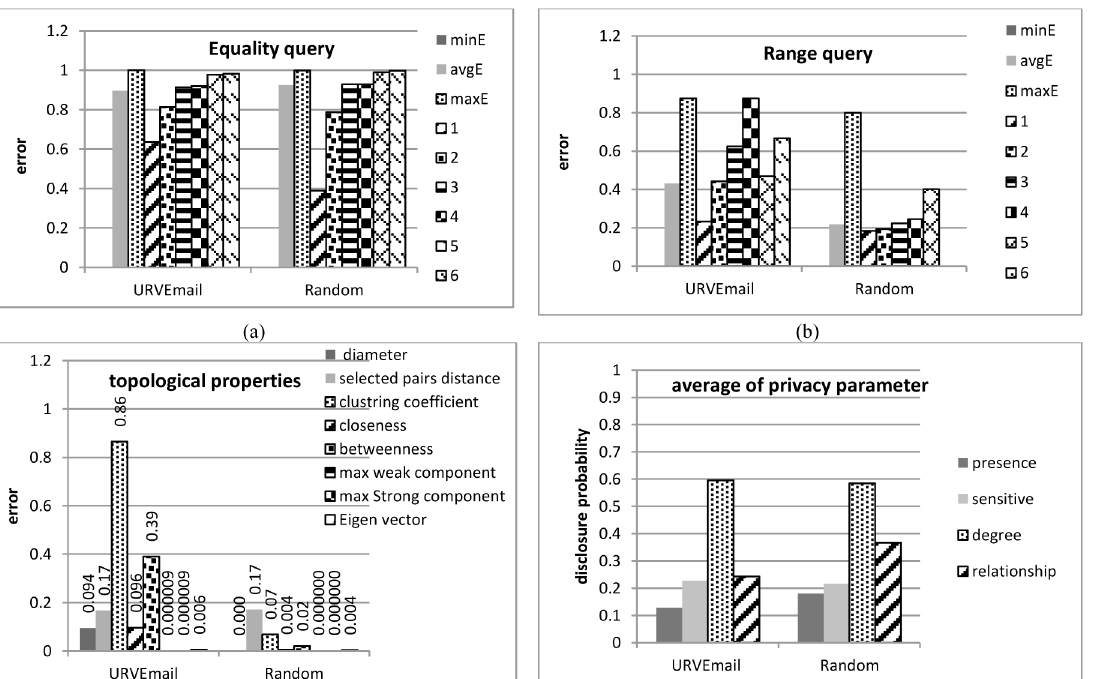
Fig 6. Information loss and privacy of released social network